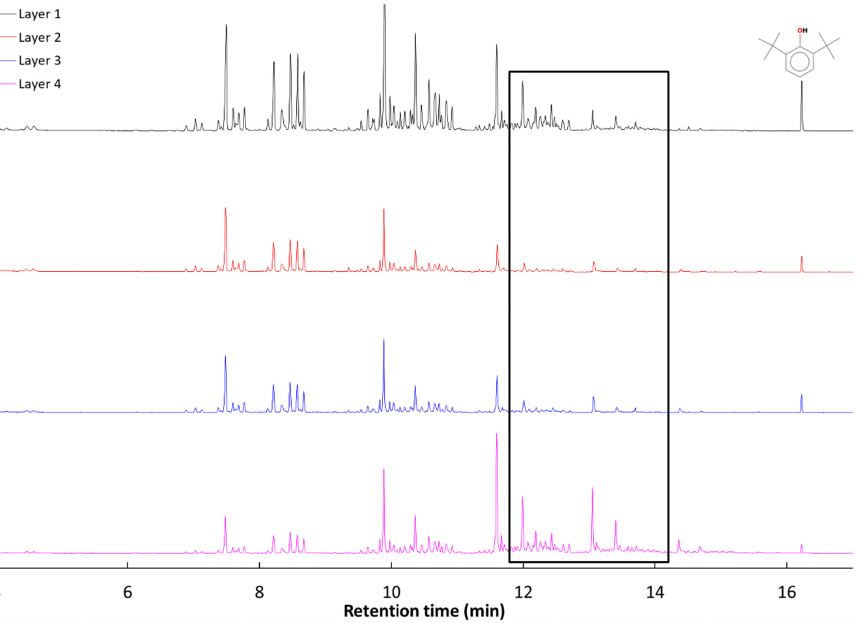
Figure 4. Chromatogram obtained by TD-GC-MS of the molecules trapped in the four layers of the Valmy FFP2 medical mask.